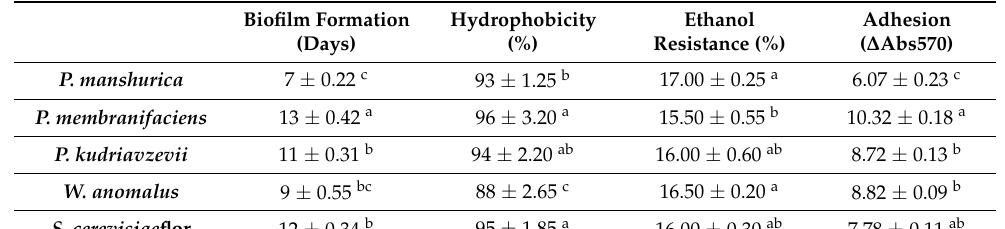
Table 2. Biofilm-forming properties (ethanol resistance (%, v / v ), biofilm (days until formation), adhesion to polystyrene (differences in absorbance at 570 nm) and hydrophobicity (%)) of the four non- Saccharomyces yeasts plus the S. cerevisiae flor used as a control. The characters a , b , and c mean significant differences at p ≤ 0.05, according to Tukey’s test.